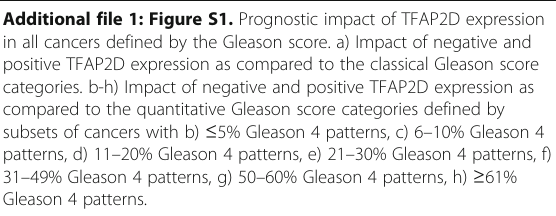
Additional file 1: Figure S1. Prognostic impact of TFAP2D expression in all cancers defined by the Gleason score. a) Impact of negative and positive TFAP2D expression as compared to the classical Gleason score categories. b-h) Impact of negative and positive TFAP2D expression as compared to the quantitative Gleason score categories defined by subsets of cancers with b) ≤ 5% Gleason 4 patterns, c) 6 – 10% Gleason 4 patterns, d) 11 – 20% Gleason 4 patterns, e) 21 – 30% Gleason 4 patterns, f) 31 – 49% Gleason 4 patterns, g) 50 – 60% Gleason 4 patterns, h) ≥ 61% Gleason 4